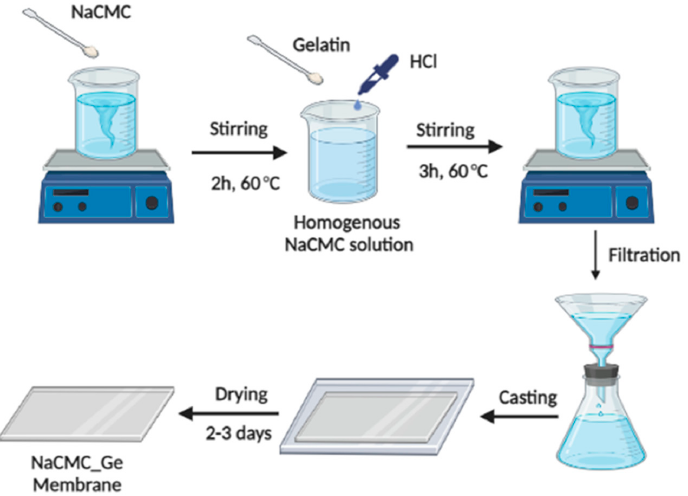
Figure 1. Scheme of the preparation of Ge-incorporated NaCMC membranes.